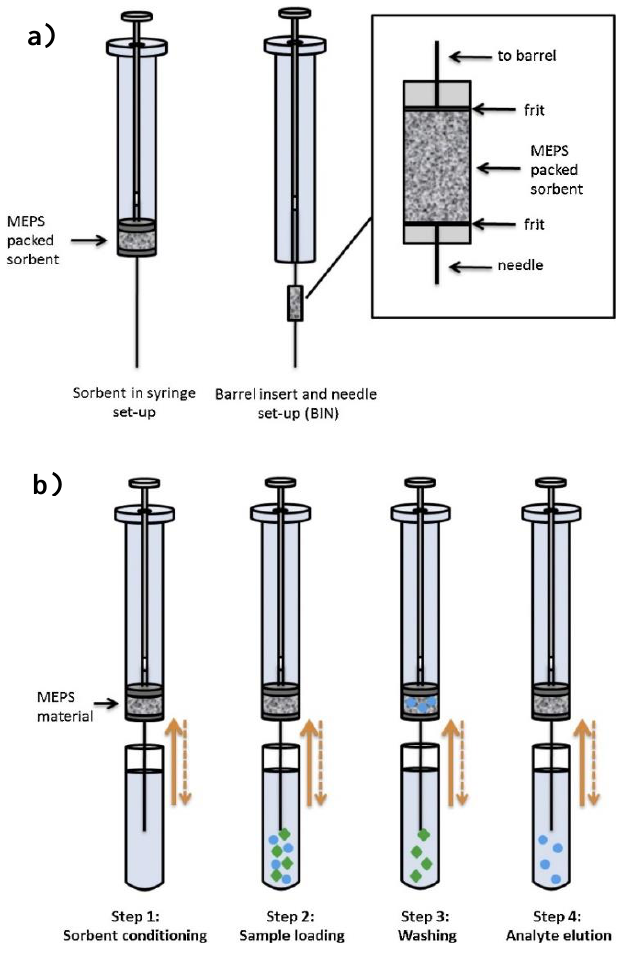
Figure 3. Microextraction by packed sorbent (MEPS) in syringe set-up and barrel insert and needle (BIN) set-up ( a ), typical MEPS procedure steps ( b ) (reprinted with permission from reference [22]).